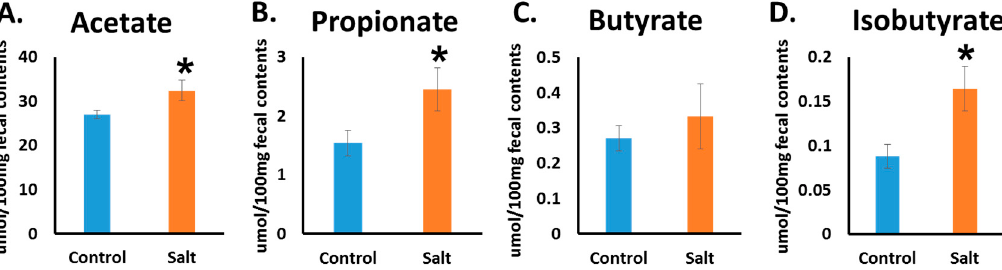
Figure 4. High salt diet elevated the SCFA level. The level of acetate ( A ); propionate ( B ); butyrate ( C ), and isobutyrate ( D ) were measured by GC-MS from fecal pellets at the end of the experiment. n = 8– 10, * p ≤ 0.05.